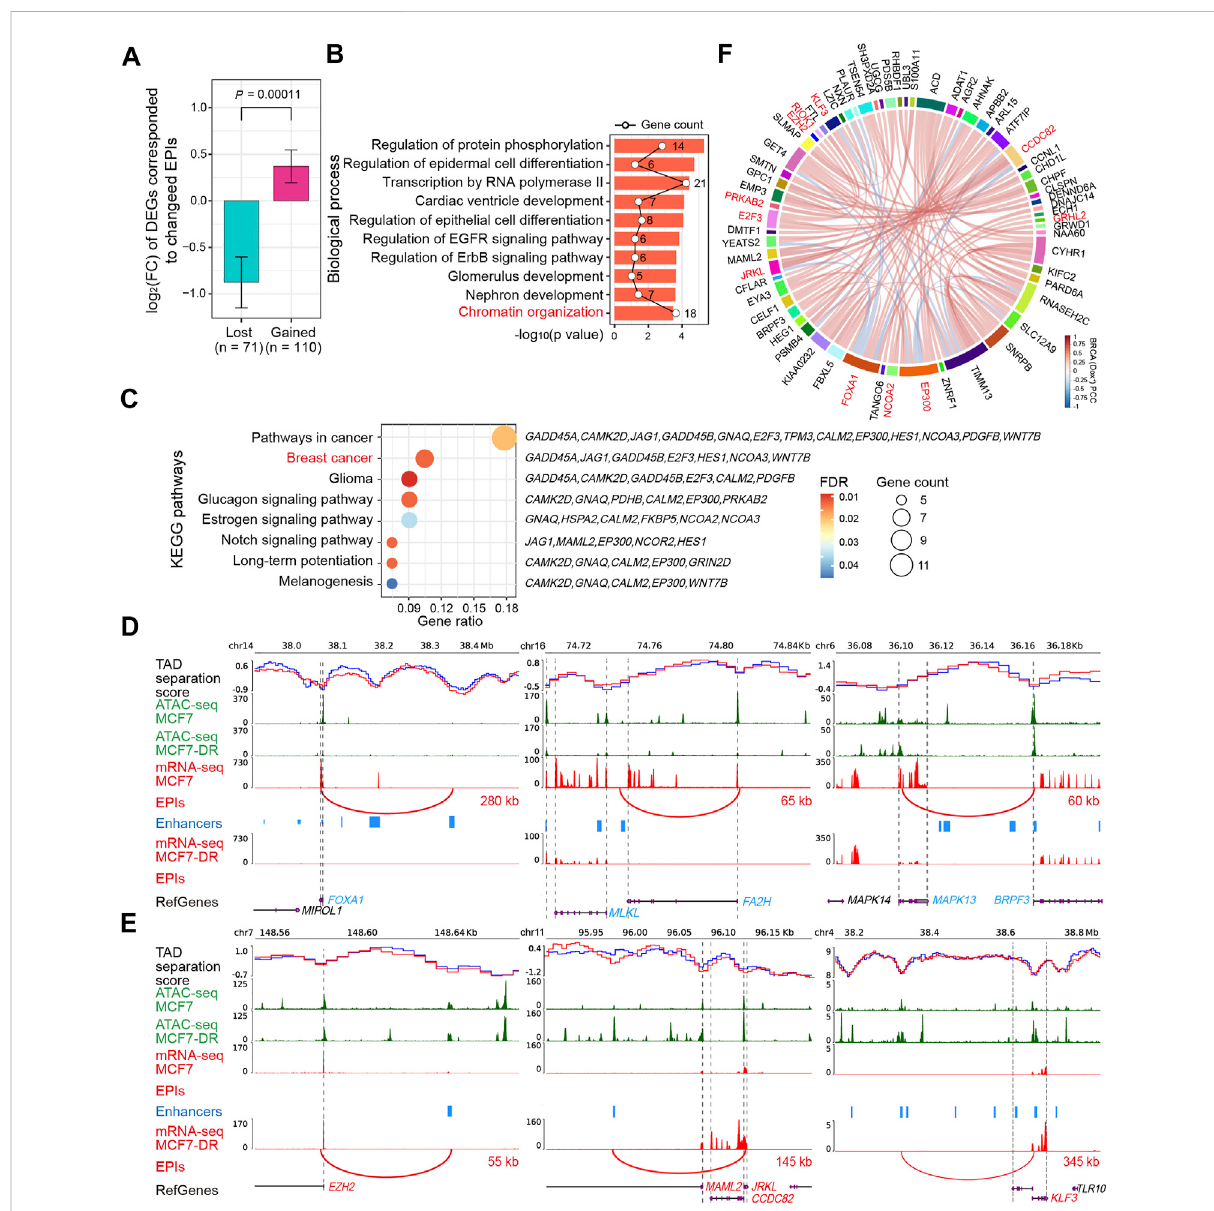
FIGURE 5 Analysisofchangedenhancer-promoterinteractionsandtheircorrespondingDEGs. (A) Theaveragelog 2 (FC)of71and110DEGscorresponded to lost and gained enhancer-promoter interactions (EPIs), respectively. Statistical signi fi cance ( p value) was evaluated using the Wilcoxon rank-sum test in R software. The number of DEGs associated with changed EPIs is displayed below the corresponding bar. FC, fold change. (B) Bar plot of signi fi cantly enriched GO terms under the “ biological process ” category for the identi fi ed DEGs in (A) . The polygonal chain in black shows the genecountrelatedtoeachterm. (C) BubbleplotrepresentingKEGGpathwayssigni fi cantlyenrichedbytheidenti fi edDEGsin (A) .Generatiorefersto the ratio of the number of genes enriched in the pathway to the total number of genes. (D,E) Representative snapshots of TAD-separation scores, ATAC-seq signals (green), mRNA-seq signals (red), enhancers (blue), changed EPIs (red) associated with down-regulated FOXA1 , FA2H , MAPK13 genes (D, blue), and up-regulated EZH2, JRKL , KLF3 (E, red) genes in MCF7-DR cells compared to parental MCF7 cells. TAD-separation scores of MCF7 and MCF7-DR cells are shown as solid blue and red lines, respectively. Lost or gained EPIs are displayed as arcsbetween thetwo genomic loci and the distance of an EPI is marked next to the arc. The black vertical dashed lines indicate the TSS or TES of DEGs. (F) Chord diagram showing the correlation between the identi fi ed DEGs corresponded to EPIs using the normalized expression matrix from breast invasive carcinoma (BRCA) patients treated with doxorubicin (adriamycin) alone in the TCGA cohort (Dox + , n = 363). The connecting chord represents a Pearson ’ s correlation coef fi cient (PCC) > 0.5 or < − 0.5. Some representative DEGs displayed in Figures 4C – E, Supplementary Figure S6 were colored in